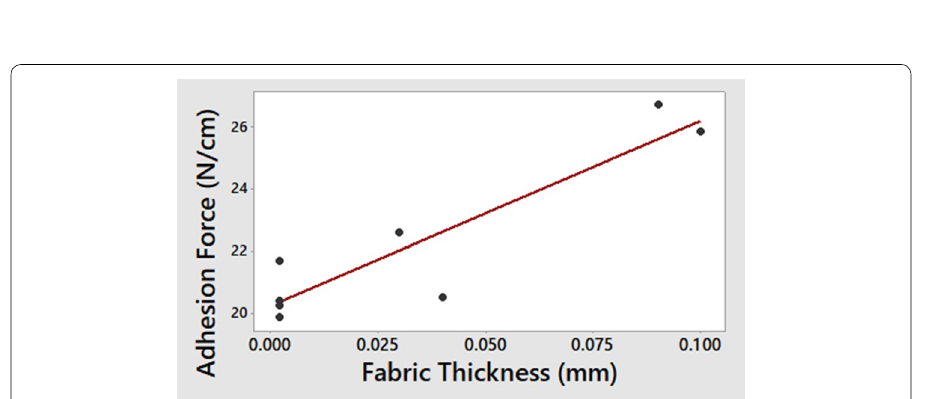
Fig. 9 Effect of fabric thickness on adhesion